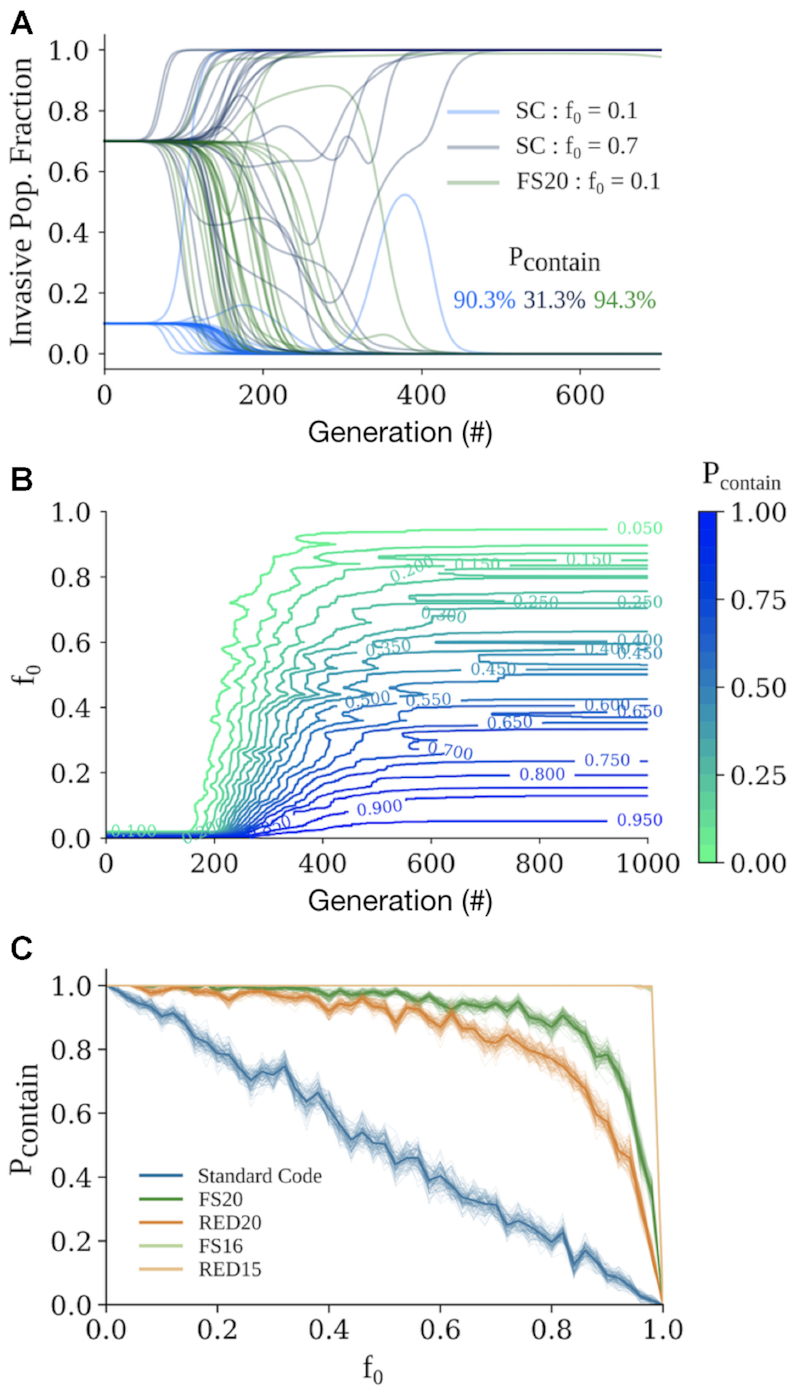
Fail-safe codes may also prevent organisms from escaping into the environment. (A) Replicates (n = 300) of simulated competition between a native population encoded in the Standard Code and a monoclonal invasive population either encoded in the Standard Code with an initial population fraction \documentclass[12pt]{minimal}
\usepackage{amsmath}
\usepackage{wasysym}
\usepackage{amsfonts}
\usepackage{amssymb}
\usepackage{amsbsy}
\usepackage{upgreek}
\usepackage{mathrsfs}
\setlength{\oddsidemargin}{-69pt}
\begin{document}
}{}${{\rm{f}}_0}$\end{document} = 10% (light blue) or 70% (dark blue), or encoded in FS20 with \documentclass[12pt]{minimal}
\usepackage{amsmath}
\usepackage{wasysym}
\usepackage{amsfonts}
\usepackage{amssymb}
\usepackage{amsbsy}
\usepackage{upgreek}
\usepackage{mathrsfs}
\setlength{\oddsidemargin}{-69pt}
\begin{document}
}{}${{\rm{f}}_0}$\end{document} = 70% (green). We approximate containment probability \documentclass[12pt]{minimal}
\usepackage{amsmath}
\usepackage{wasysym}
\usepackage{amsfonts}
\usepackage{amssymb}
\usepackage{amsbsy}
\usepackage{upgreek}
\usepackage{mathrsfs}
\setlength{\oddsidemargin}{-69pt}
\begin{document}
}{}${{\rm{P}}_{{\rm{contain}}}}$\end{document} as the fraction of simulations in which the invasive population is eliminated. (B) Contour graphs of containment probability vs. time (x axis) and \documentclass[12pt]{minimal}
\usepackage{amsmath}
\usepackage{wasysym}
\usepackage{amsfonts}
\usepackage{amssymb}
\usepackage{amsbsy}
\usepackage{upgreek}
\usepackage{mathrsfs}
\setlength{\oddsidemargin}{-69pt}
\begin{document}
}{}${{\rm{f}}_0}$\end{document} (y axis) for invasive strains using the Standard Code (n = 300 replicates). Color represents \documentclass[12pt]{minimal}
\usepackage{amsmath}
\usepackage{wasysym}
\usepackage{amsfonts}
\usepackage{amssymb}
\usepackage{amsbsy}
\usepackage{upgreek}
\usepackage{mathrsfs}
\setlength{\oddsidemargin}{-69pt}
\begin{document}
}{}${{\rm{P}}_{{\rm{contain}}}}$\end{document} magnitude, varying from 0 (green) to 1 (blue). \documentclass[12pt]{minimal}
\usepackage{amsmath}
\usepackage{wasysym}
\usepackage{amsfonts}
\usepackage{amssymb}
\usepackage{amsbsy}
\usepackage{upgreek}
\usepackage{mathrsfs}
\setlength{\oddsidemargin}{-69pt}
\begin{document}
}{}${{\rm{P}}_{{\rm{contain}}}}$\end{document} reaches a steady state value at the limit of large \documentclass[12pt]{minimal}
\usepackage{amsmath}
\usepackage{wasysym}
\usepackage{amsfonts}
\usepackage{amssymb}
\usepackage{amsbsy}
\usepackage{upgreek}
\usepackage{mathrsfs}
\setlength{\oddsidemargin}{-69pt}
\begin{document}
}{}$\rm{t}$\end{document}. (C) \documentclass[12pt]{minimal}
\usepackage{amsmath}
\usepackage{wasysym}
\usepackage{amsfonts}
\usepackage{amssymb}
\usepackage{amsbsy}
\usepackage{upgreek}
\usepackage{mathrsfs}
\setlength{\oddsidemargin}{-69pt}
\begin{document}
}{}${{\rm{P}}_{{\rm{contain}}}}$\end{document} at steady state versus \documentclass[12pt]{minimal}
\usepackage{amsmath}
\usepackage{wasysym}
\usepackage{amsfonts}
\usepackage{amssymb}
\usepackage{amsbsy}
\usepackage{upgreek}
\usepackage{mathrsfs}
\setlength{\oddsidemargin}{-69pt}
\begin{document}
}{}${{\rm{f}}_0}$\end{document} for invasive strains using fail-safe codes (n = 300 replicates). Bootstrapped-resampled traces of the data (lighter shaded lines) are shown with colors as in Figure 3B.